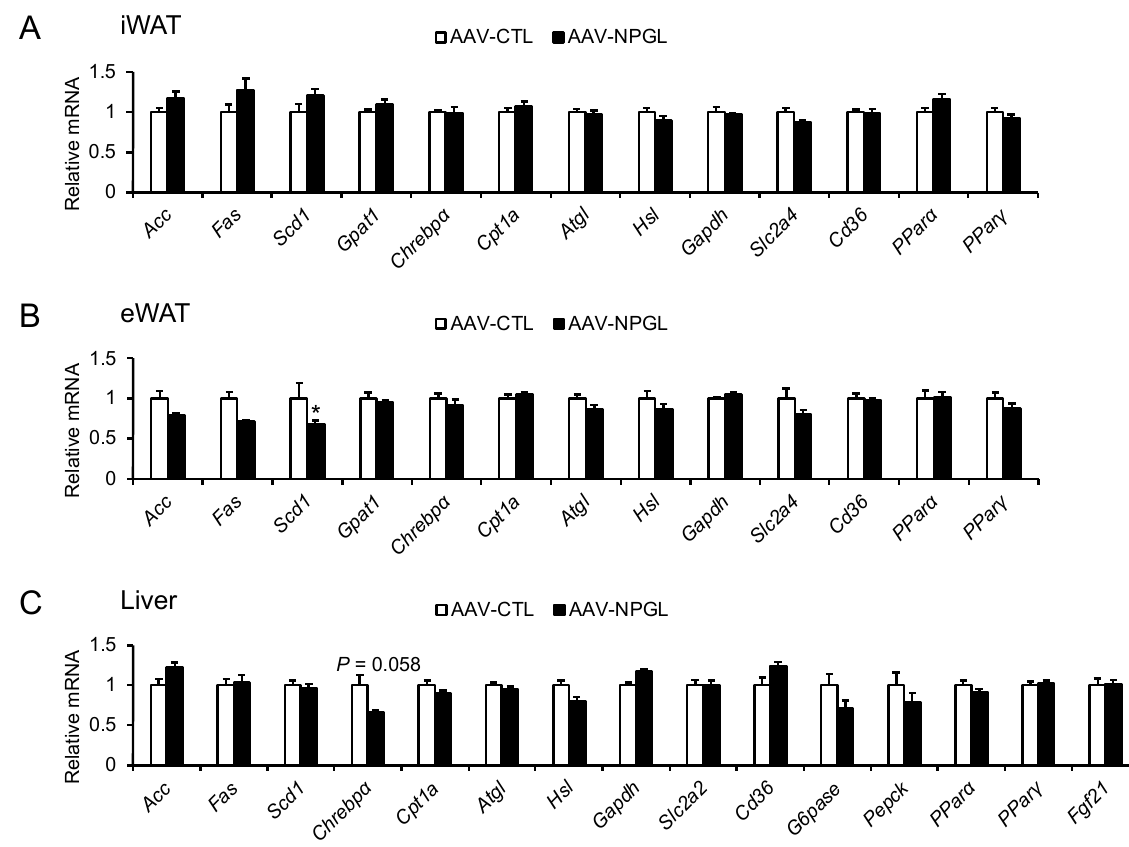
Figure 6. Effects of Npgl overexpression on mRNA expression of genes regulating lipid metabolism in mice fed a high-fat diet with 60% calories from fat. These mice were injected with an adeno-associated virus (AAV) vector, either a control (AAV-CTL) or a vector carrying the NPGL precursor gene (AAV-NPGL). ( A – C ) mRNA expression levels in the ( A ) inguinal white adipose tissue (iWAT), ( B ) epididymal white adipose tissue (eWAT), and ( C ) liver. All statistical analyses were performed using two-way ANOVA followed by Bonferroni’s test. Each value represents the mean ± standard error of the mean (AAV-CTL: n = 8, AAV-NPGL: n = 8; * p < 0.05).